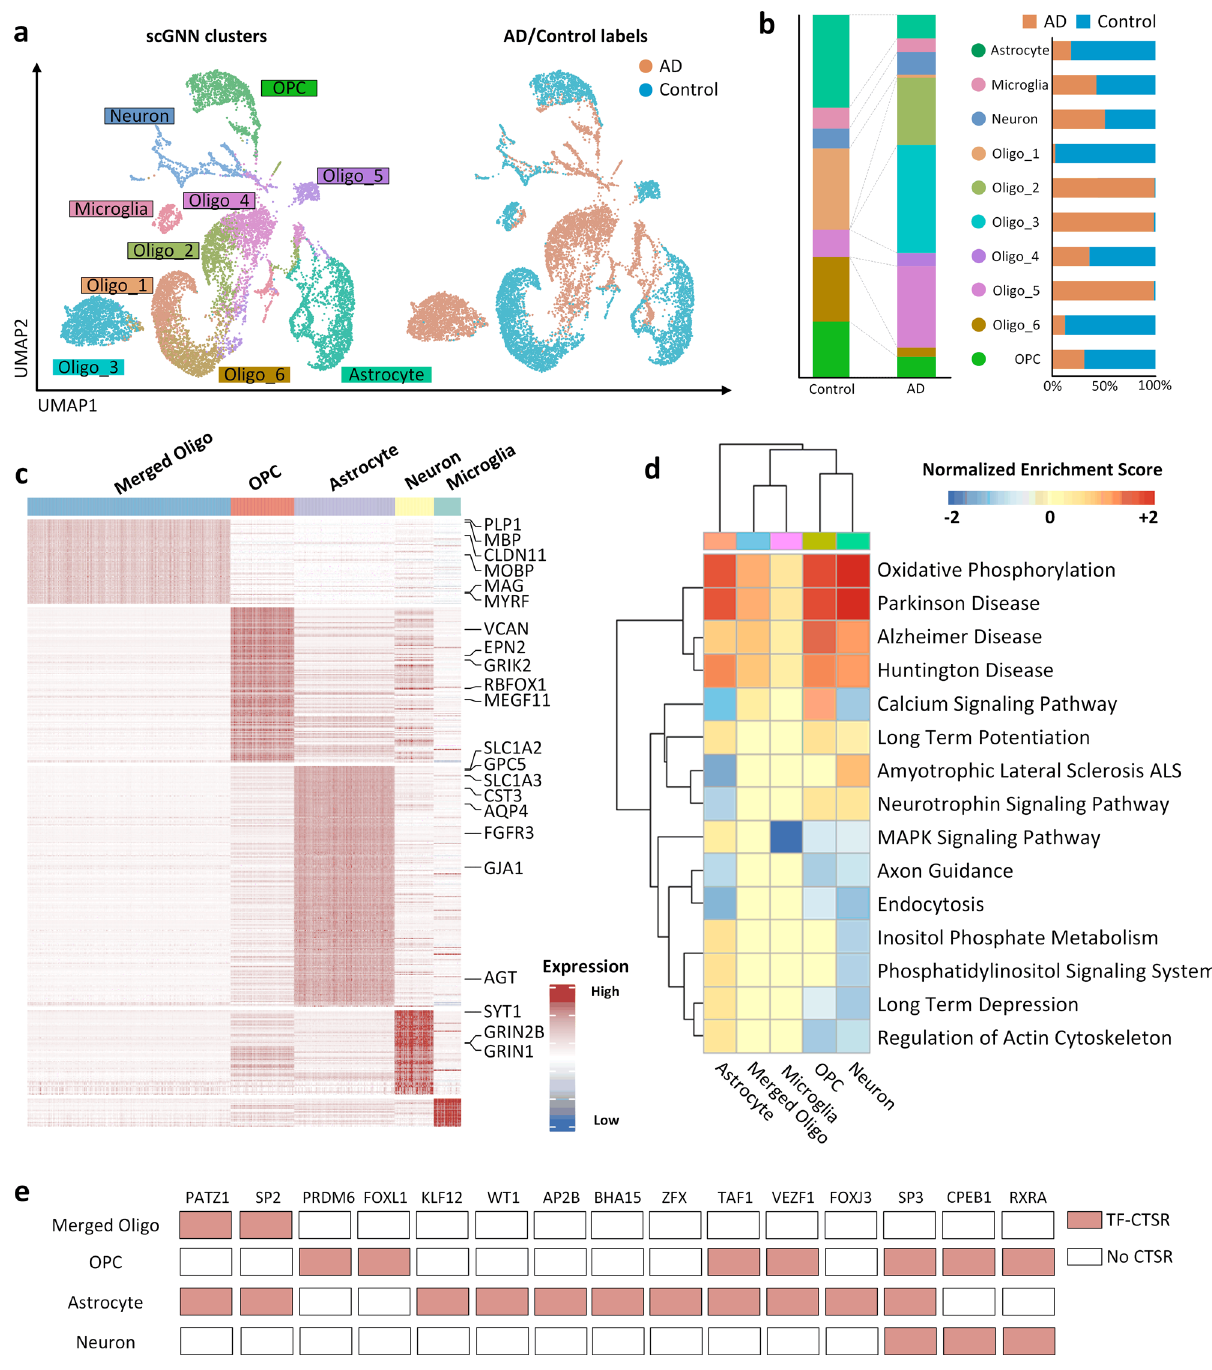
Fig. 5 Alzheimer ’ s disease data set (GSE138852) analysis based on scGNN. a Cell clustering UMAP. Labeled with scGNN clusters (left) and AD/control samples (right). b Comparison of cell proportions in AD/control samples (left) and each cluster (right). c Heatmap of DEGs (logFC > 0.25) in each cluster. Six oligodendrocyte sub-clusters are merged as one to compare with other cell types. Marker genes identi fi ed in DEGs are listed on the right. d Selected AD-related enrichment pathways in each cell type in the comparison between AD and control cells. e Underlying TFs are responsible for the cell-type- speci fi c gene regulations identi fi ed by